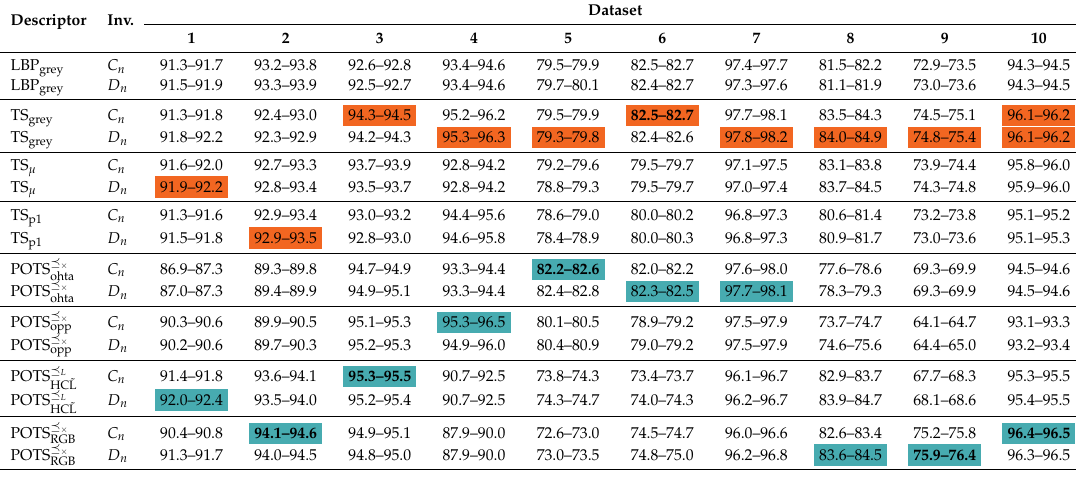
Table 2. Overall classification accuracy: confidence intervals for the cross-validated accuracy ˆ a . Best results highlighted for grey-level (orange) and colour space features (blue). Boldface figures indicate statistically significant